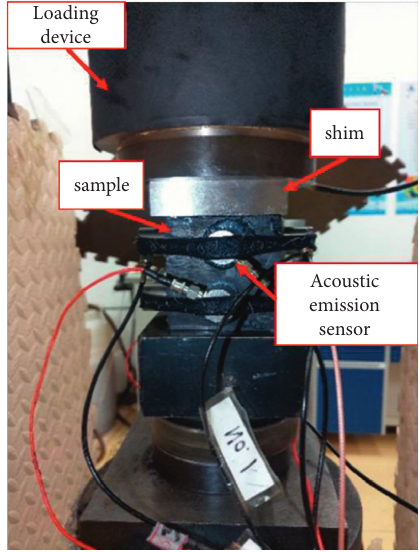
Figure 3: Loading of raw coal